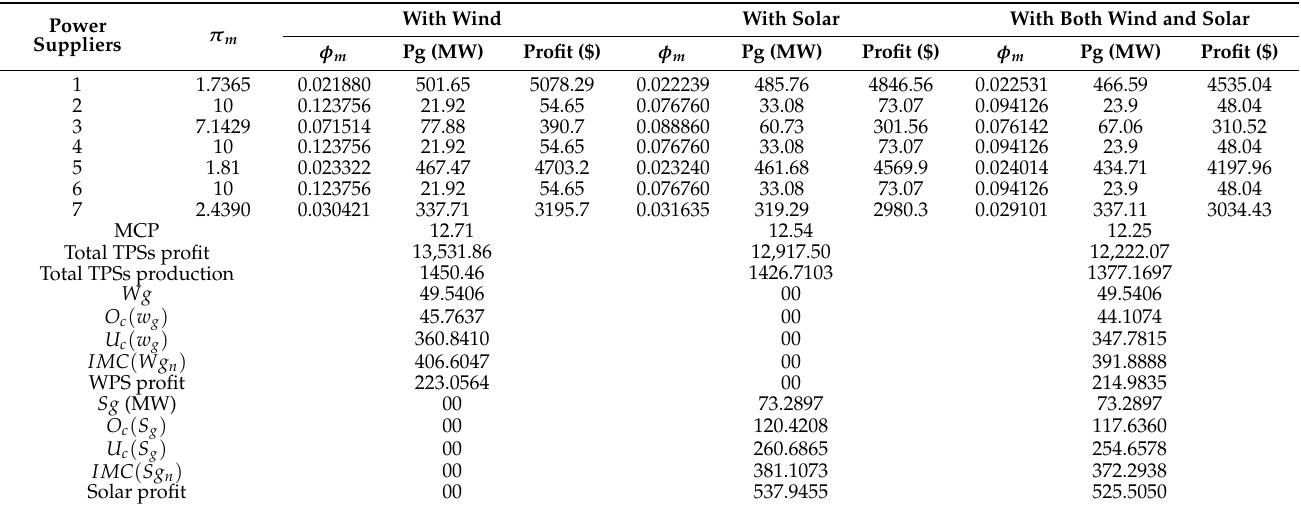
Table 9. Results for standard IEEE 57-bus system with